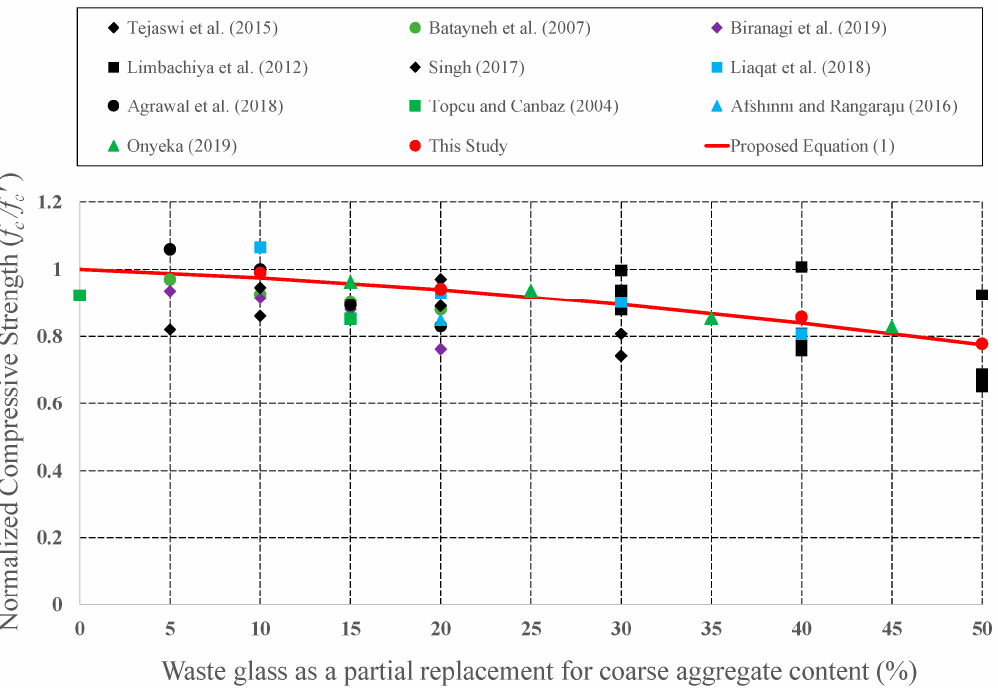
Figure 8. Discrepancy of the normalized CS of the concrete formed with CWG as a partial replacement for CA [39,40,47,58–62,78,79].